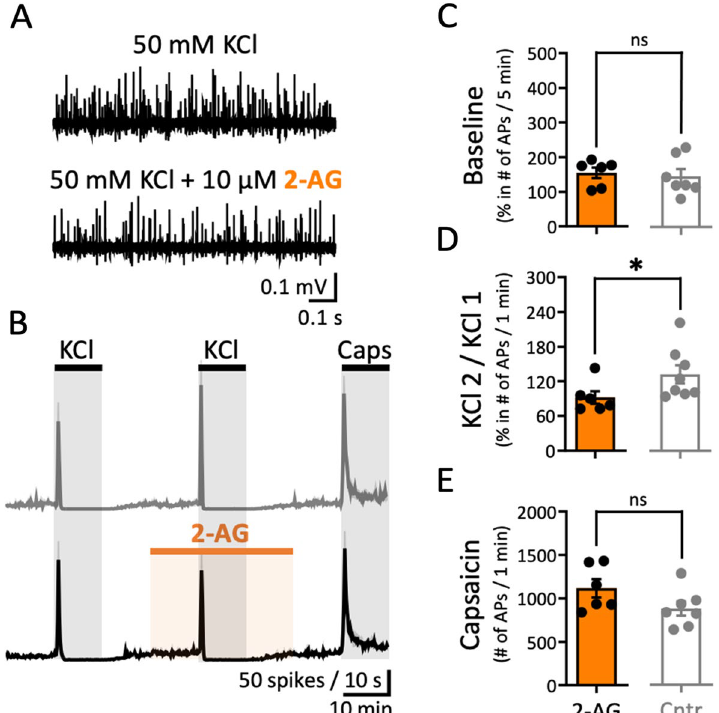
Fig. 5 Exogenous 2‑AG mildly reduces meningeal nerve endings nociceptive firing. A Example traces of APs recorded from the peripheral part of the rat trigeminal nerve within control, i.e. during the 1‑min active phase of the 1 st KCl pulse and the corresponding phase of the 2 nd KCl pulse when also 10 µM 2‑AG was present. Note the slight decrease of general nociceptive firing that was obtained during the combined application. B Time courses of spike frequency (10‑s bin size) induced by paired pulses of KCl and 1 µM Capsaicin as control (data of the top panel in Fig. 4B) and during the combined application of 10 µM 2‑AG with the 2 nd KCl pulse (bottom panel). C No difference was observed for the number of APs induced when comparing a ratio of the 5‑min windows before/after application of 2‑AG ( N 6) to the same windows of the ratio spontaneous = spiking activity in the control condition (Cntr, N 7; data representation from Fig. 4B). D 2‑AG application significantly reduced the number of APs = during the 1‑min active phase of the 2 nd KCl pulse compared to that of the 1 st KCl pulse. The ratio of APs (between 2 nd and 1 st (taken as 100%) KCl pulse) in the control (Cntr , N 8; data representation from Fig. 4C) condition resulted higher than in the presence of 2‑AG ( N 6, Mann Whitney = = test, * 0.02). E No difference was observed for the number of APs during the 1‑min active phase of 1 µM Capsaicin of the control condition (Cntr , = N 7; data representation from Fig. 4D) and after application of 2‑AG ( N = =